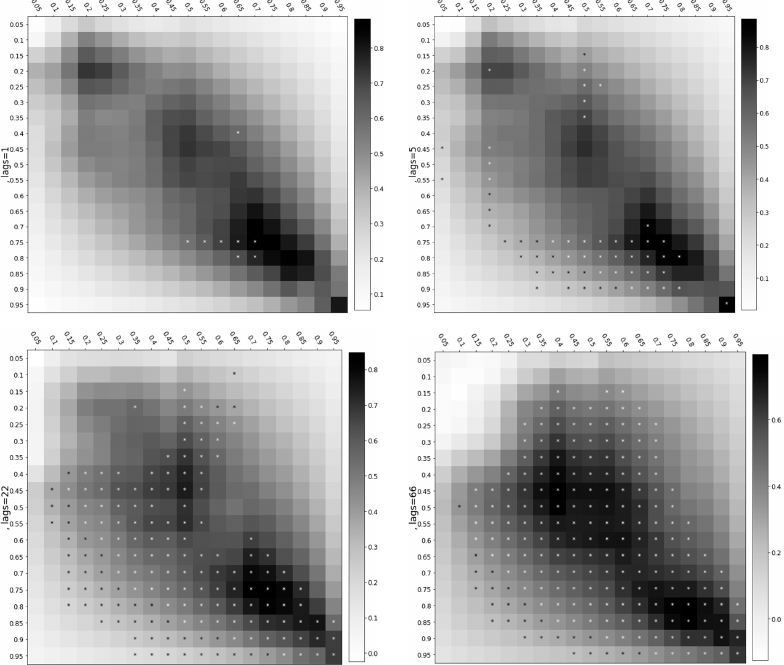
Figure 13. Cross-quantile dependency from Johnson & Johnson to Moderna. Notes: The vertical axis indicates the quantile distribution of Johnson & Johnson’s stock return, whereas the horizontal axis indicates the quantile distribution of Moderna’s stock return. The white to black intensity in the bar indicates negative to positive associations.